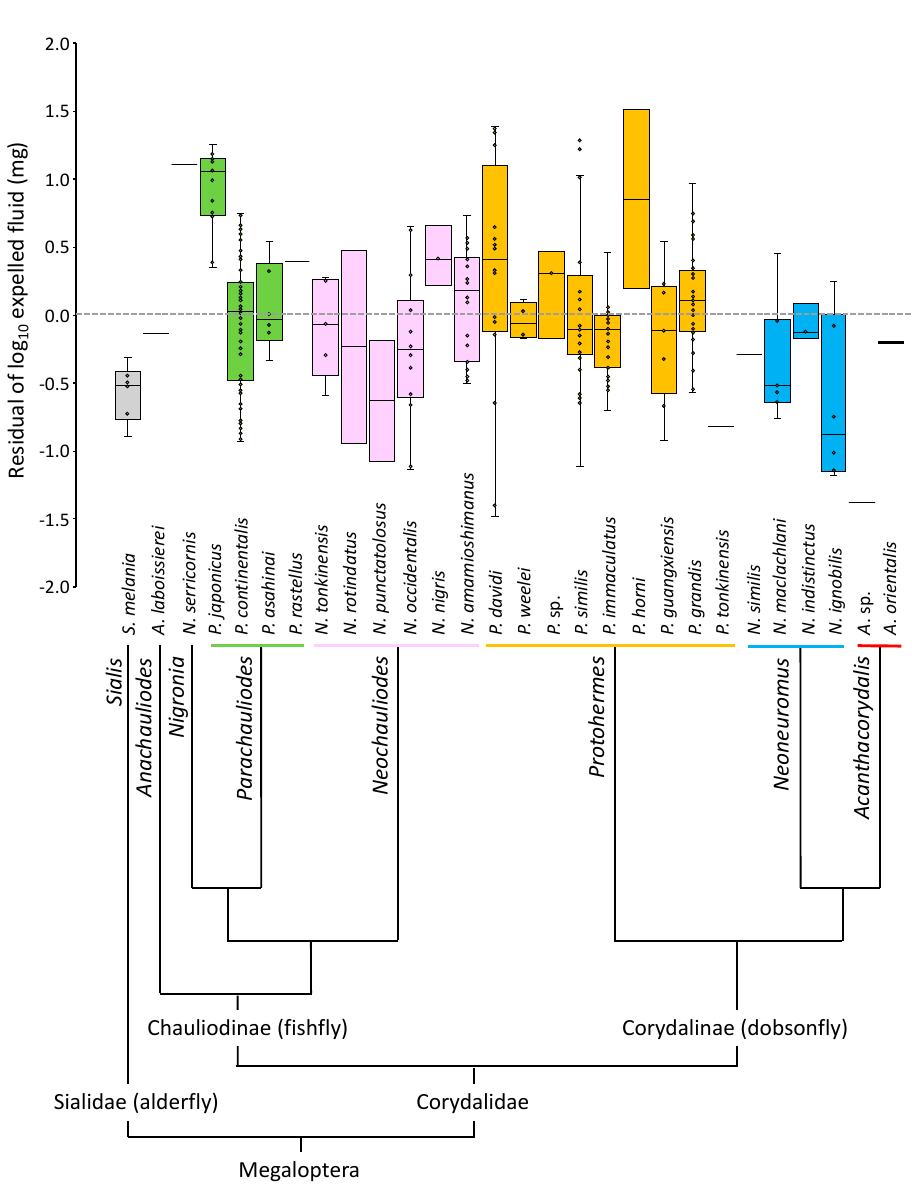
Figure 2. The box plots of the relative weight of the expelled fluid to body size in 1 species of alderflies, 12 species of fishflies and 15 species of dobsonflies plotted on their phylogenetic tree at the genus level [19]. For an explanation of the log-scale residual of the expelled fluid weight, see the statistics section in the main text.